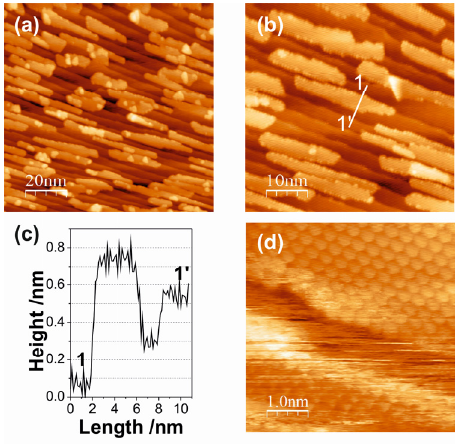
Figure 6. ( a , b ) STM images of 0.28 ML ceria on Au(788); ( a ) (100 × 100) nm 2 ; V S = 2.2 V; I T = 22.0 pA. ( b ) (50 × 50) nm 2 ; V S = 1.7 V; I T = 16.8 pA. ( c ) Line scan along the solid line in ( b ). ( d ) High resolution STM image of a ceria island surface ((5 × 5) nm 2 ; V S = 0.1 V; I T = 350